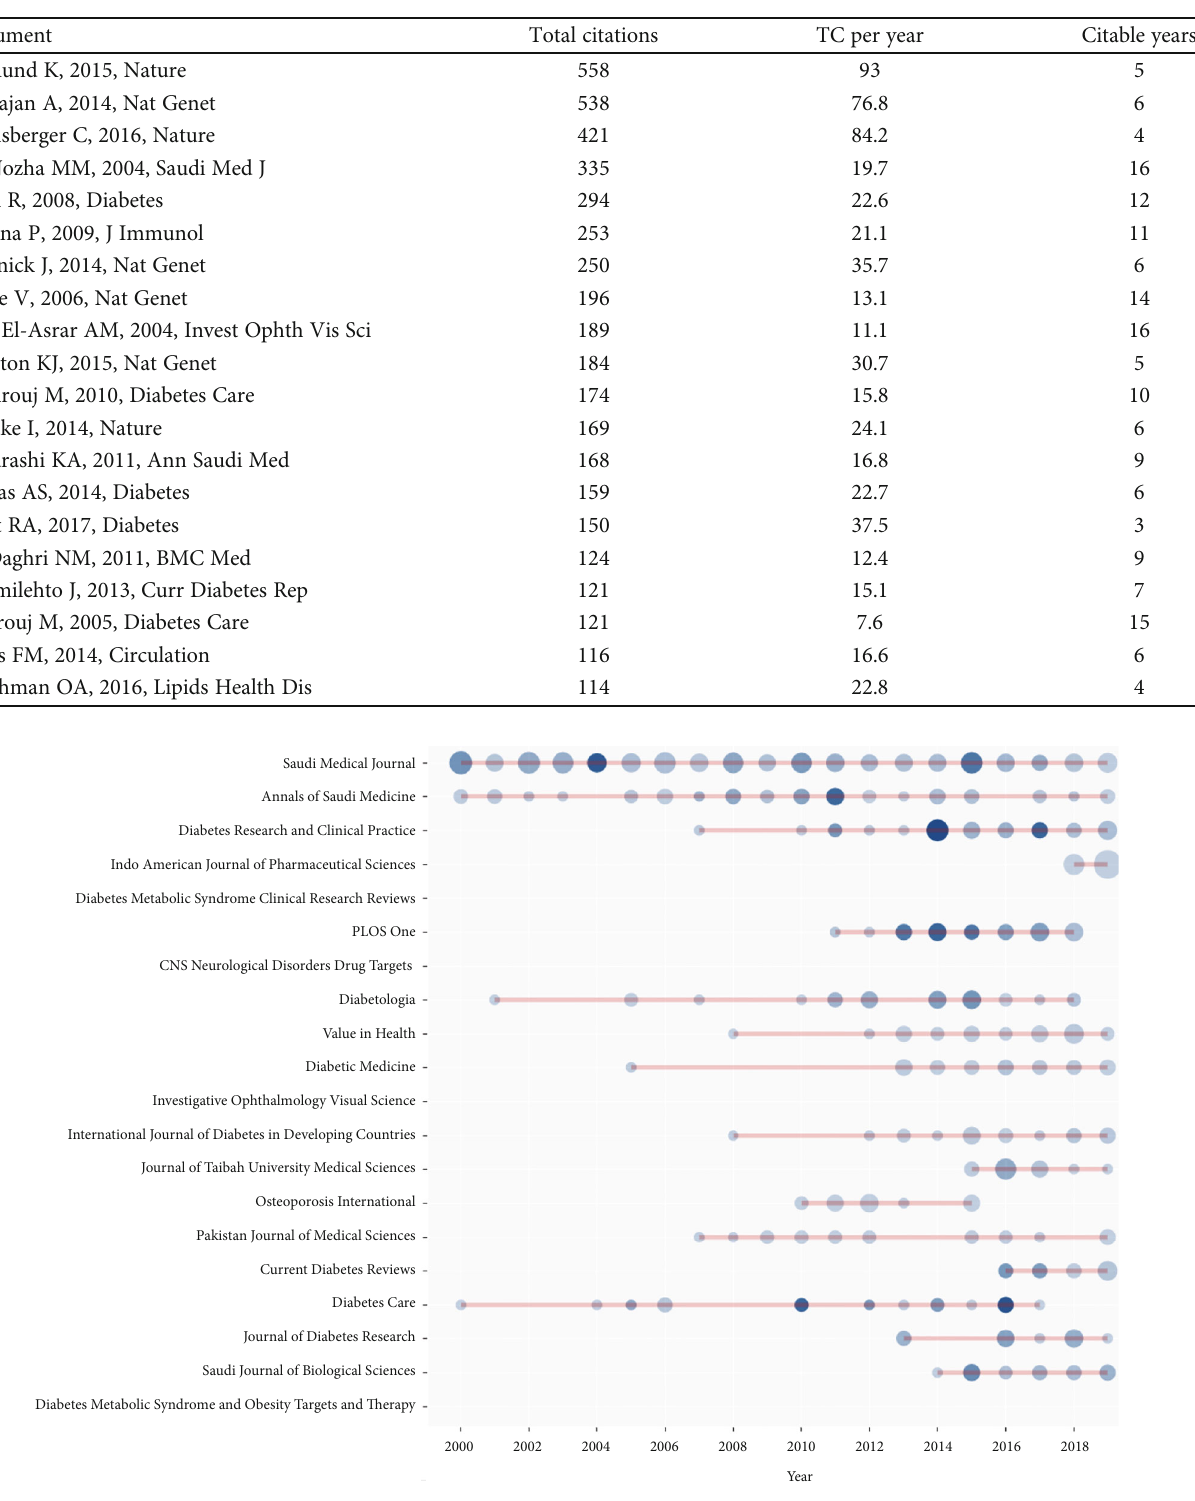
Figure 3: Year-wise distribution of the 20 most productive sources with citations. ∗ Size of circle represents the number of articles, and color represents the number of